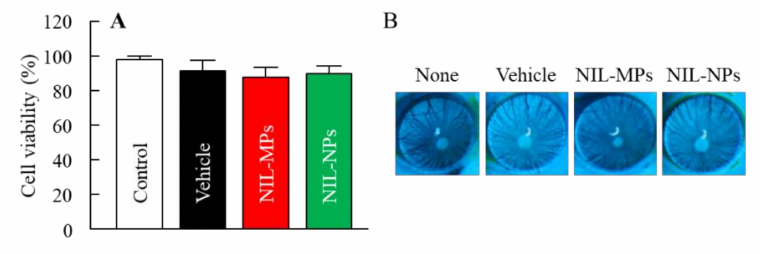
Figure 5. Corneal toxicity in the instillation of NIL-NP dispersions. ( A ) Effect of NIL treatment on cell viability in HCE-T cells. ( B ) Corneal image in rats repetitively instilled with NIL-NP dispersions. Twenty microliters of NIL ophthalmic formulations were repetitively instilled with the right eye three times a day for 2 months. n = 5. No significant damage was observed in the groups treated with NIL-MP or NIL-NP dispersions.